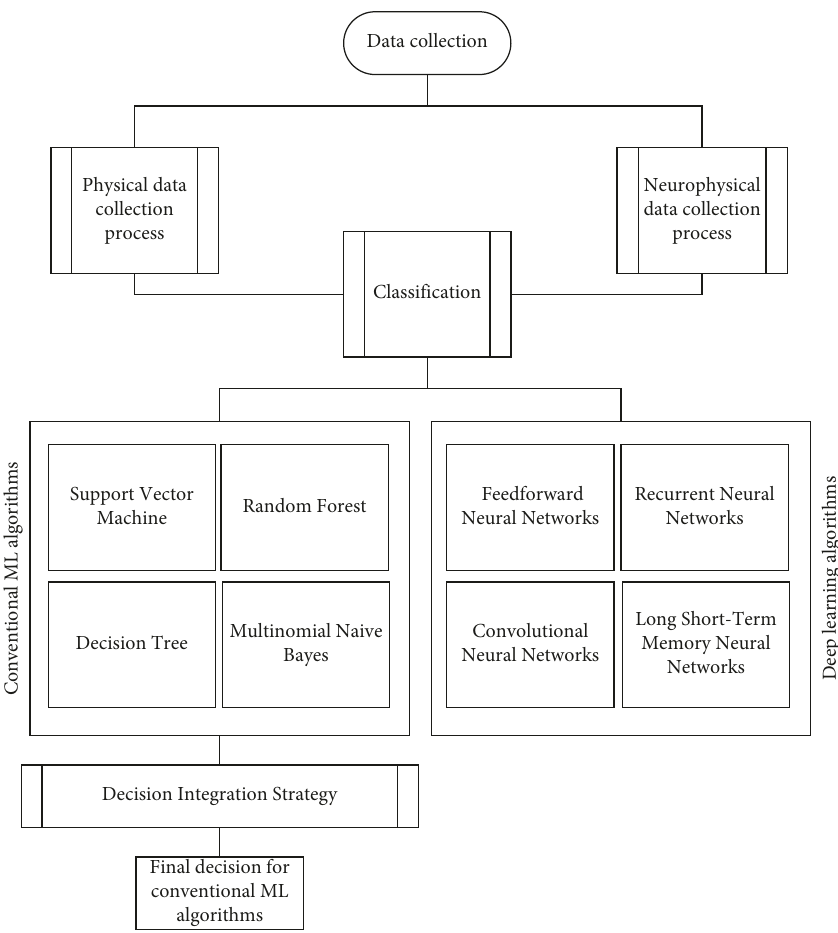
Figure 1: Flowchart of the proposed system.